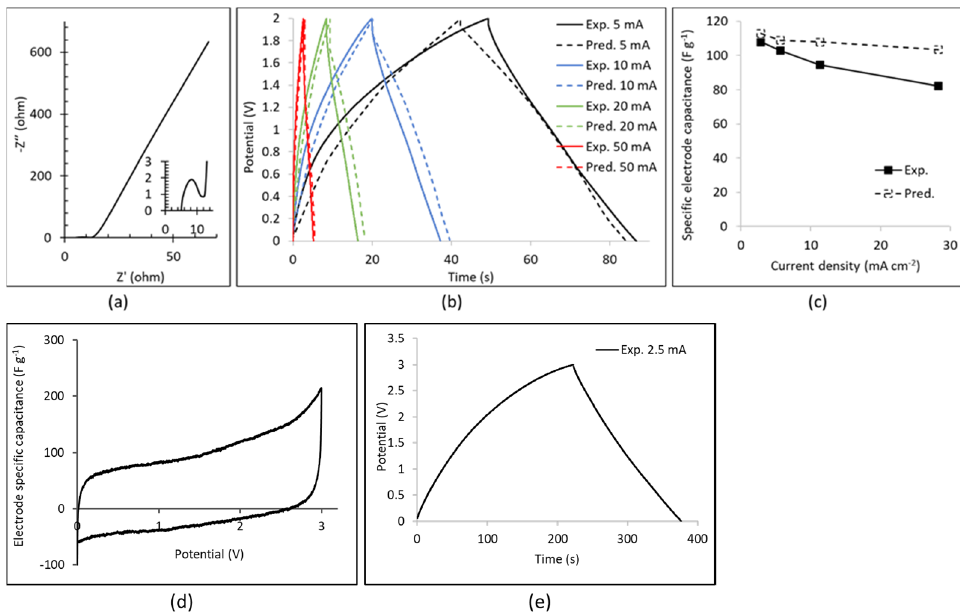
Figure 6. Results of the experimental study and computer simulation for the symmetric EDLC of 1.77 cm 2 with xGNP-750 composite coating electrodes and electrolyte 1M LiPF 6 in EC:DMC. ( a ) Nyquist impedance plot from the EIS test data; ( b ) GCD curves at different currents: experimental data and simulation predictions; ( c ) Plot of specific electrode capacitance versus current density: experimental data and simulation predictions; ( d ) CV test plot in the range of 0–3 V at 5 mV s − 1 ; ( e ) GCD test plot in the range of 0–3 V at 2.5